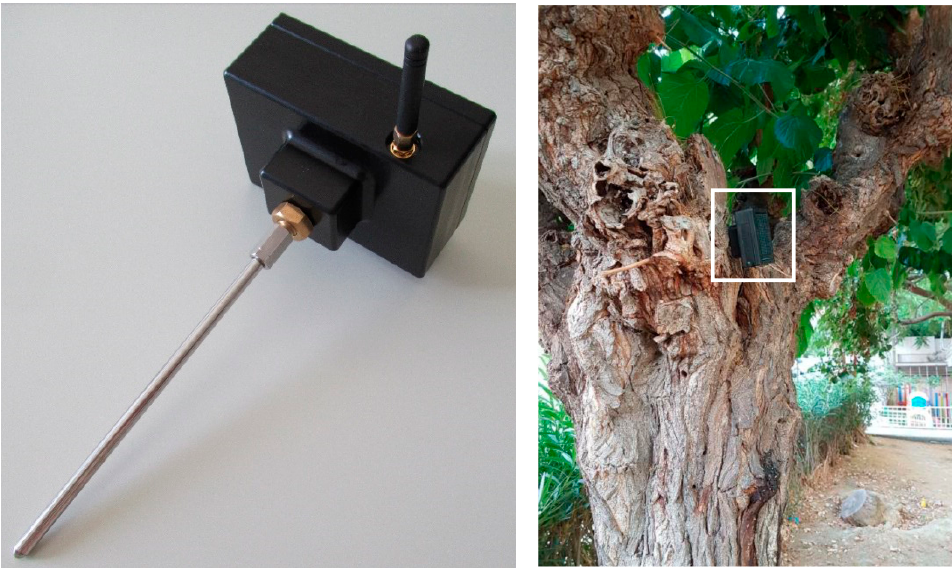
Figure 2. Left: the device is a recorder of vibrations that are picked up by the metal probe. Right: the device attached to a mulberry listening for the cerambycid pest Xylotrechus chinensis .